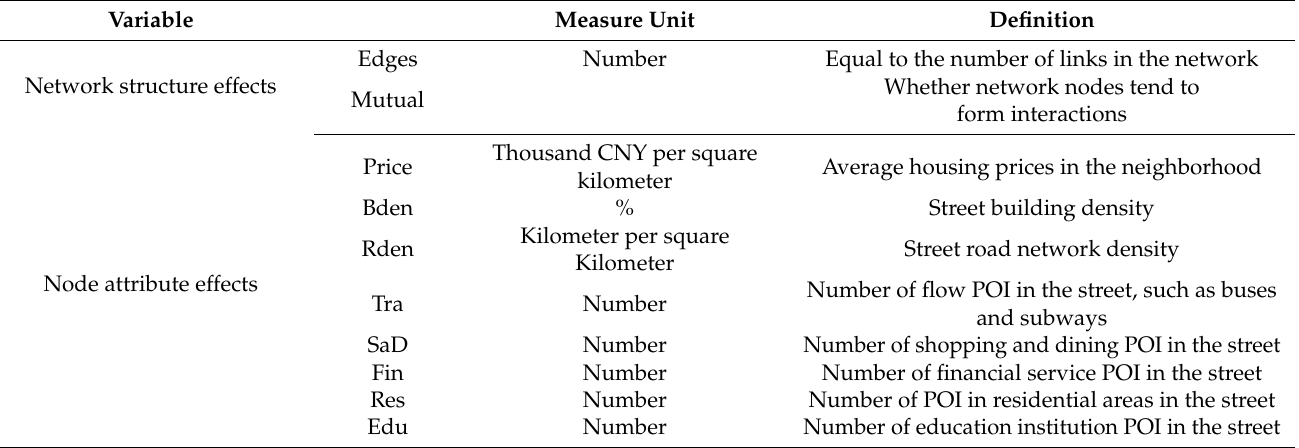
Table 3. Definitions of variables in the ERGM